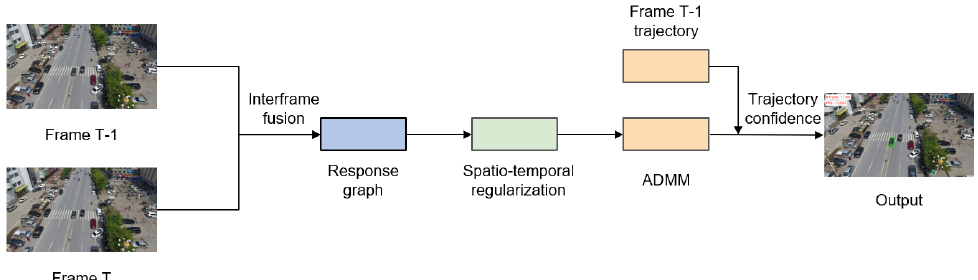
Figure 1. The general framework